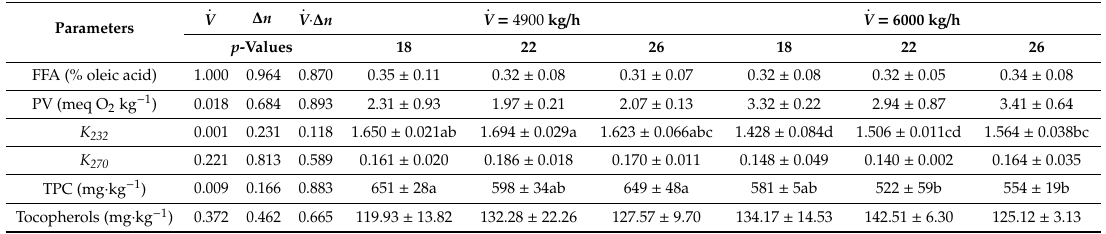
Table 5. Two-way ANOVA model summary, quality indices of the oils (mean ± standard deviation, n = 2), and results of the Fisher’s least significant di ff erence (LSD) test for multiple